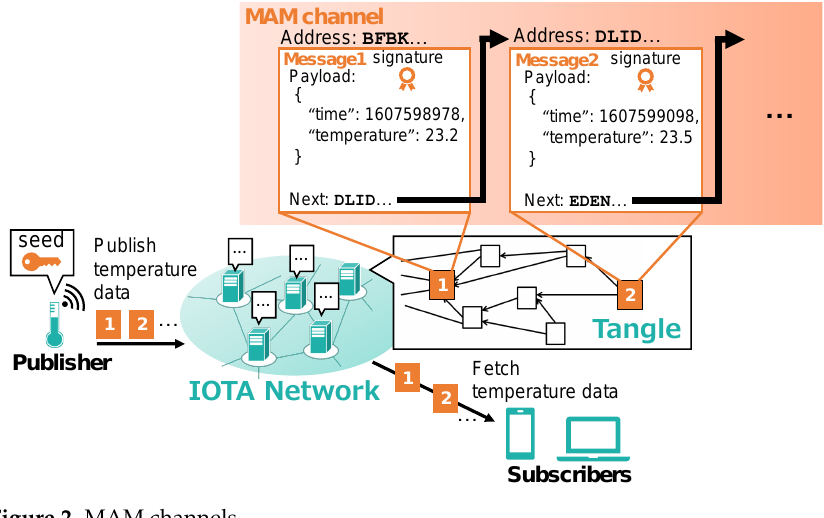
Figure 2. MAM channels.